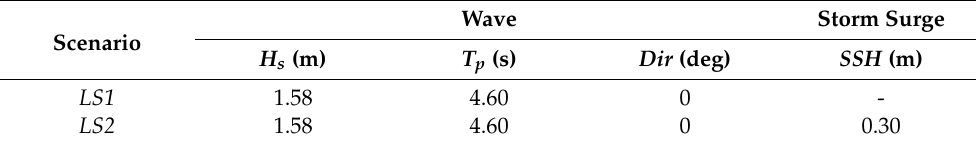
Table 2. Scenarios used for the large-scale